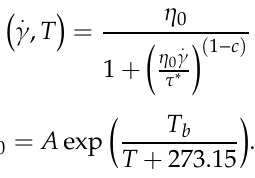
Table 3. Parameters of the Cross